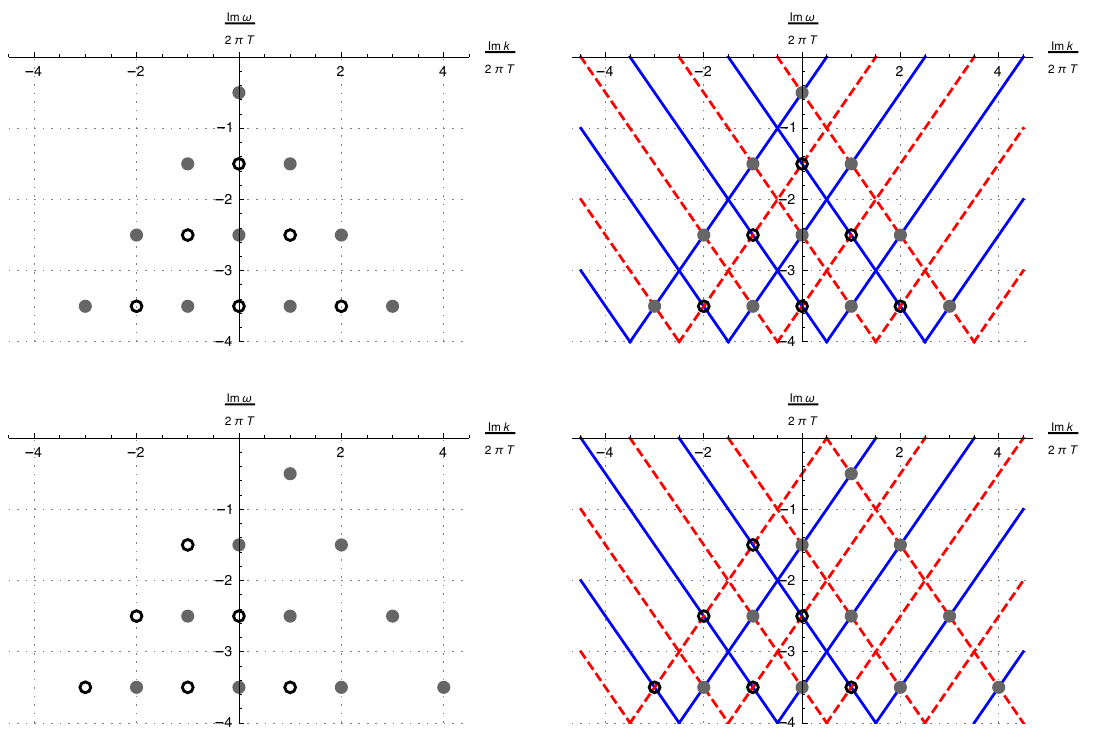
Figure 1 . Plots of the locations of pole-skipping points for the fermionic Green’s function in the BTZ black hole background. The top row is for m = 0 and the bottom row shows the locations for m = 1. The left column shows only the locations of the pole-skipping points as predicted from the near horizon analysis. The gray points correspond to the momentum written with a positive sign in and the hollow points correspond to the momenta with a negative sign as written in (7.12). Comparing the top left and bottom left panel we notice that, by increasing the mass, the gray points get rigidly translated to the right by the value of m and the hollow points get translated by an equal amount to the left. The right column has superimposed the lines of zeros (red, dashed) from (7.1.2) and lines of poles (blue) from (7.1.2). For both values of the mass the near-horizon analysis predicts the location of the intersections of lines of zeros and lines of